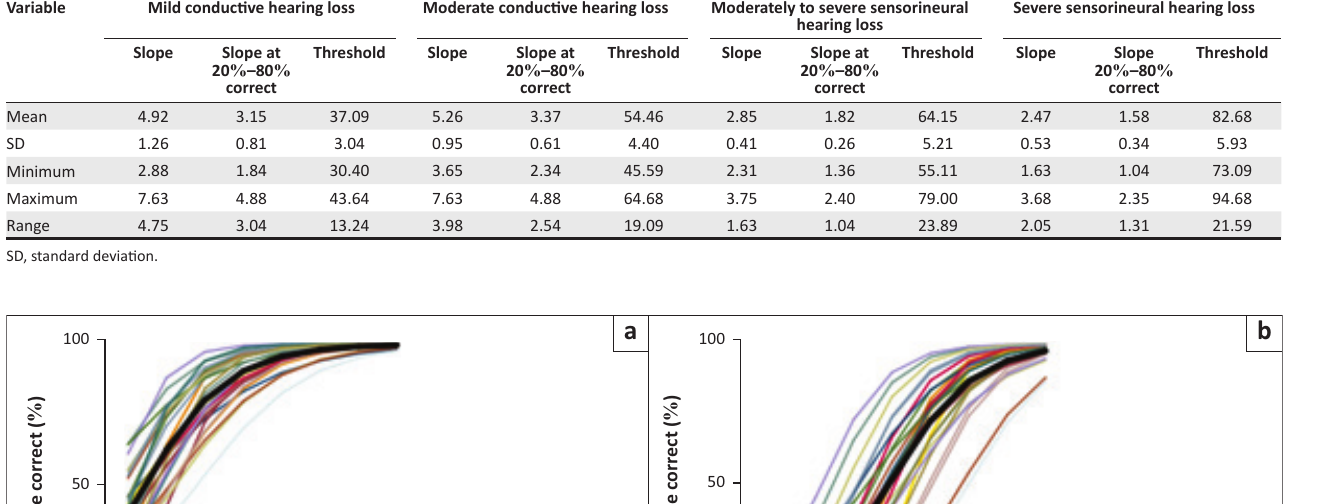
TABLE 4: Psychometric function measures for the 28 isiZulu words for the participants by degree of hearing loss. Variable